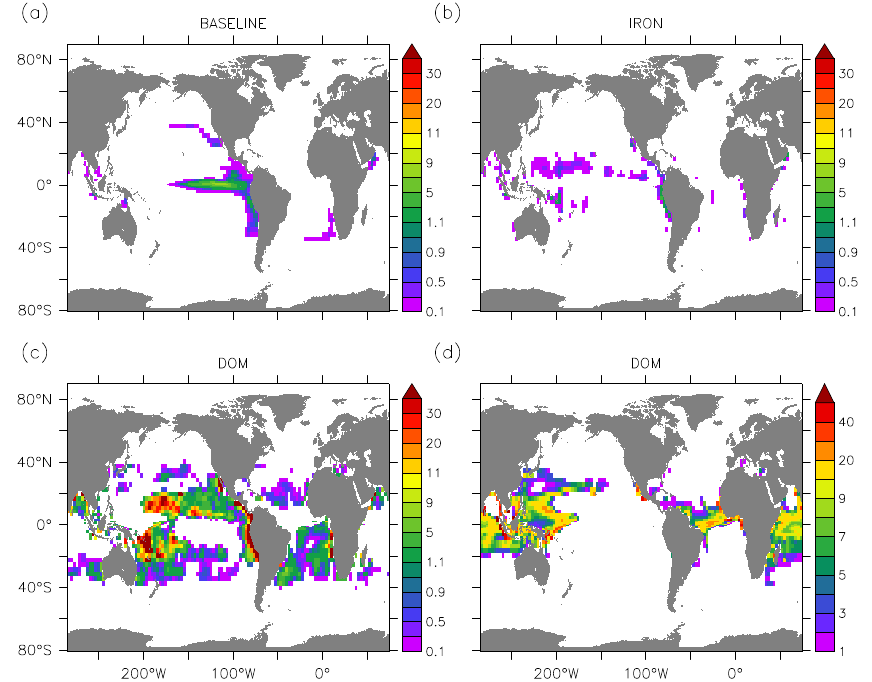
Fig. 4. NO − uptake of diazotrophs (mmolNm − 2 yr − 1 ) in the (a) BASELINE (b) IRON and (c) DOM simulations. DOP uptake 3 (mmolPm − 2 yr − 1 ) in the (d) DOM simulation. Figure shows averages over 150 model